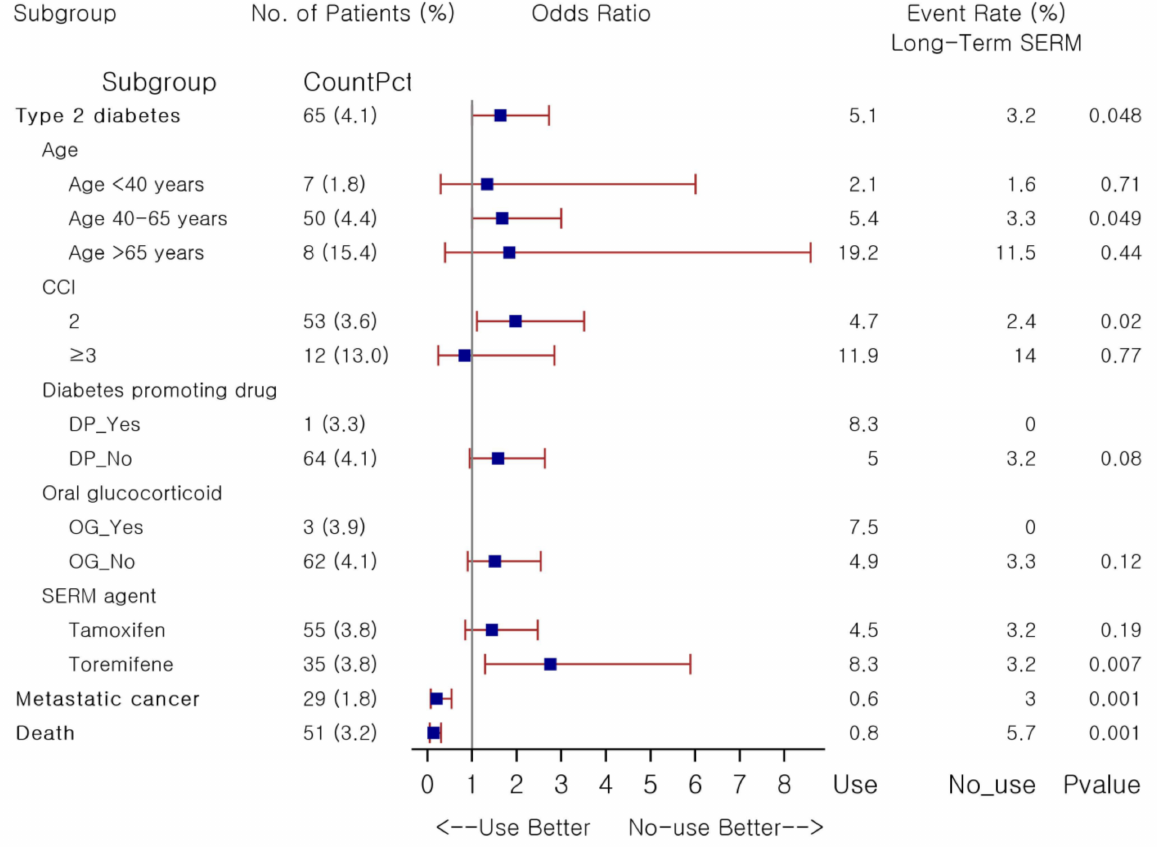
Figure 1. Forest plot for association between study outcomes and long-term use of SERMs in female patients with breast cancer. Abbreviations: SERM, selective estrogen receptor modulator; CCI, Charlson Comorbidity Index; DP, diabetes promoting drug; OG, oral